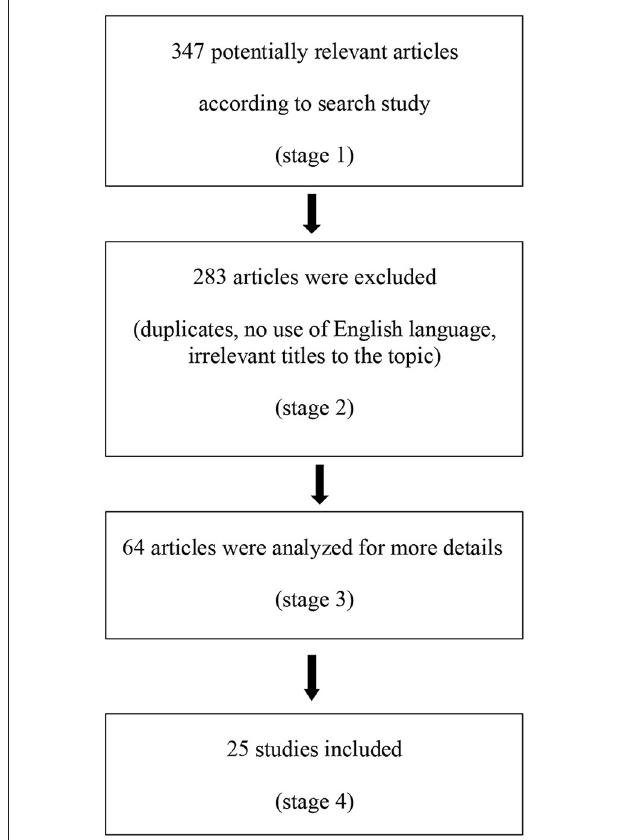
FIGURE 1 | Flow diagram of the study